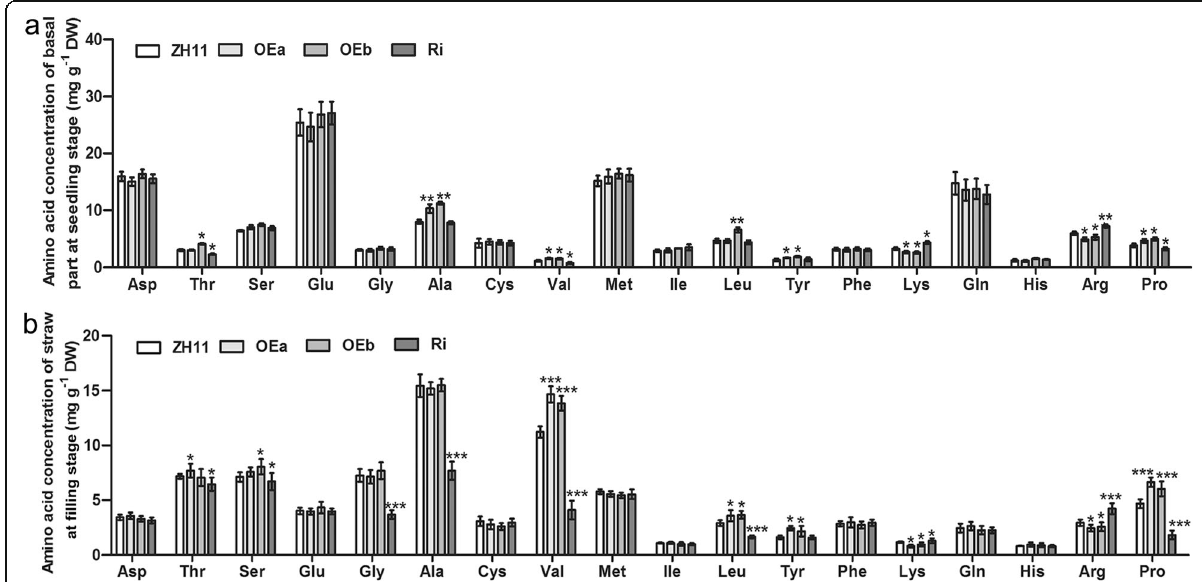
Fig. 4 Effect of OsAAP4 on amino acid concentrations among ZH11, OEa, OEb, and Ri lines. Amino acid concentrations of basal parts at seedlings stage ( a ) and straw at filling stage ( b ). OEa, OEb, and Ri indicated that mixed equal-amount which extracted from each three OEa, OEb, and Ri lines, respectively. The letters above the error bars are ranked by the T test, “ * ” indicates a significant difference at p <0.05, “ ** ” indicates a significant difference at p <0.01, and “ *** ” indicates a significant difference at p <0.001. Values are means ± s.d. ( n